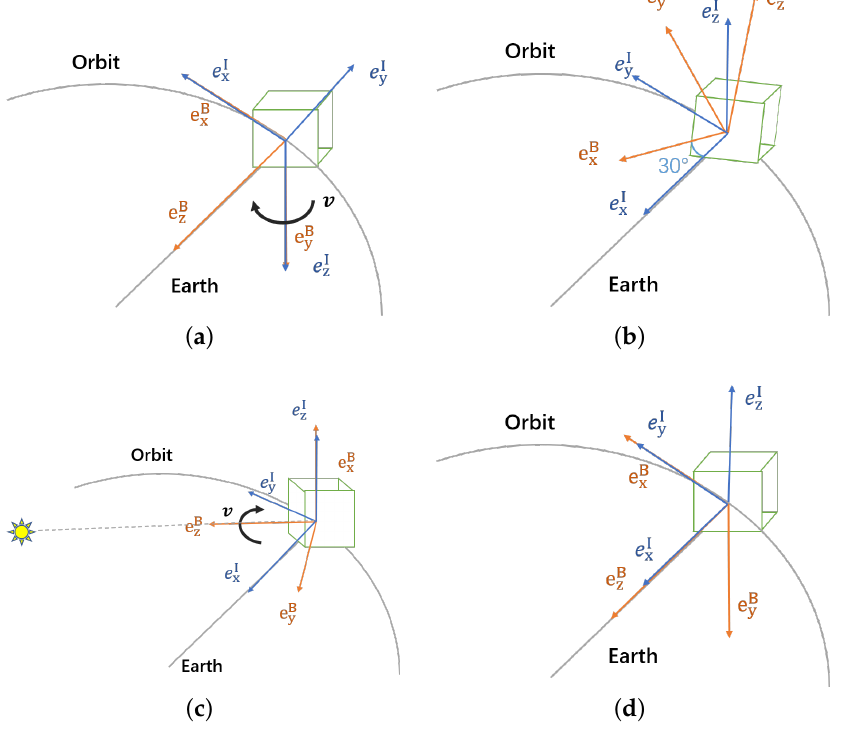
Figure 4. Diagram of the four attitudes: ( a ) attitude 1; ( b ) attitude 2; ( c ) attitude 3; ( d ) attitude